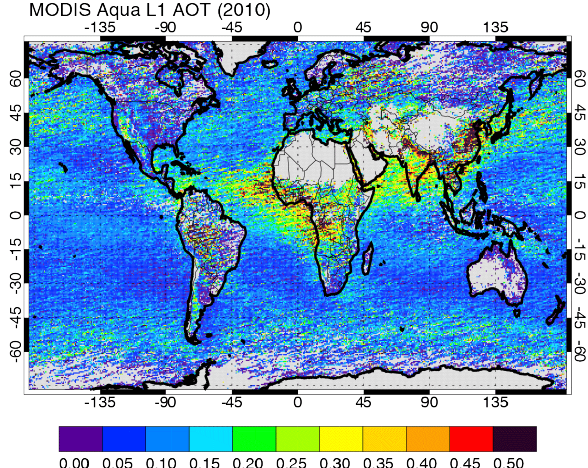
Figure 13. As in Fig. 3d, the year 2010 annual mean AOT gridded at 0 . 625 ◦ × 0 . 5 ◦ horizontal resolution for the L1 across-track MODIS